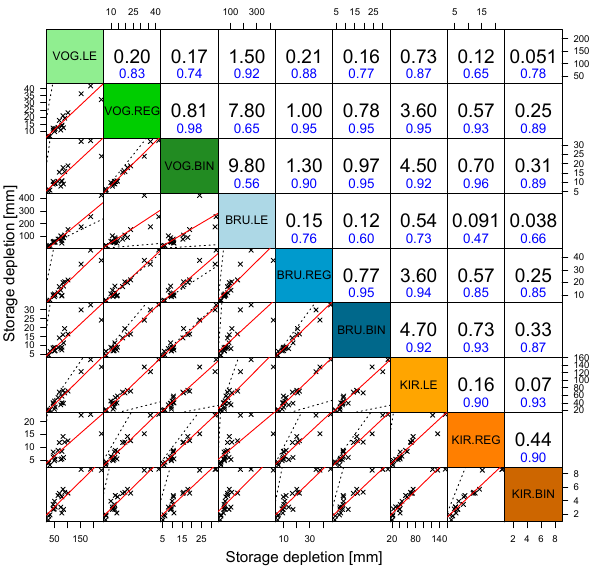
Fig. 4. Below diagonal: scatterplots for calculated storage deple- tion from each combination of RAMs with a linear regression (red line) and the 1 : 1 line (dashed line). Above diagonal: corresponding slope (black) and adjusted R 2 (blue) of the linear